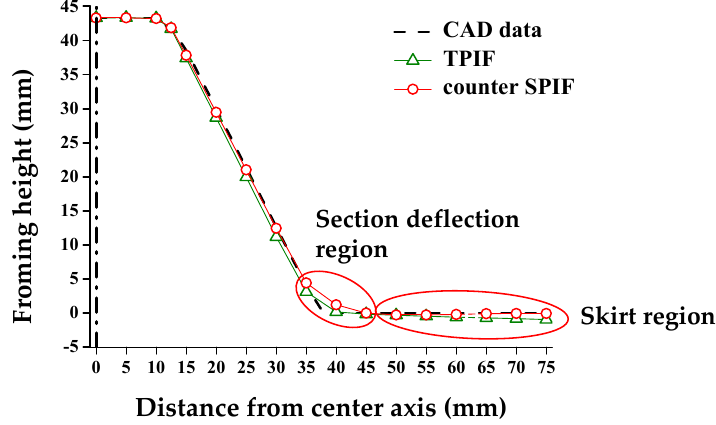
Figure 14. Comparison of the cross-sectional shape in TPIF and counter SPIF.